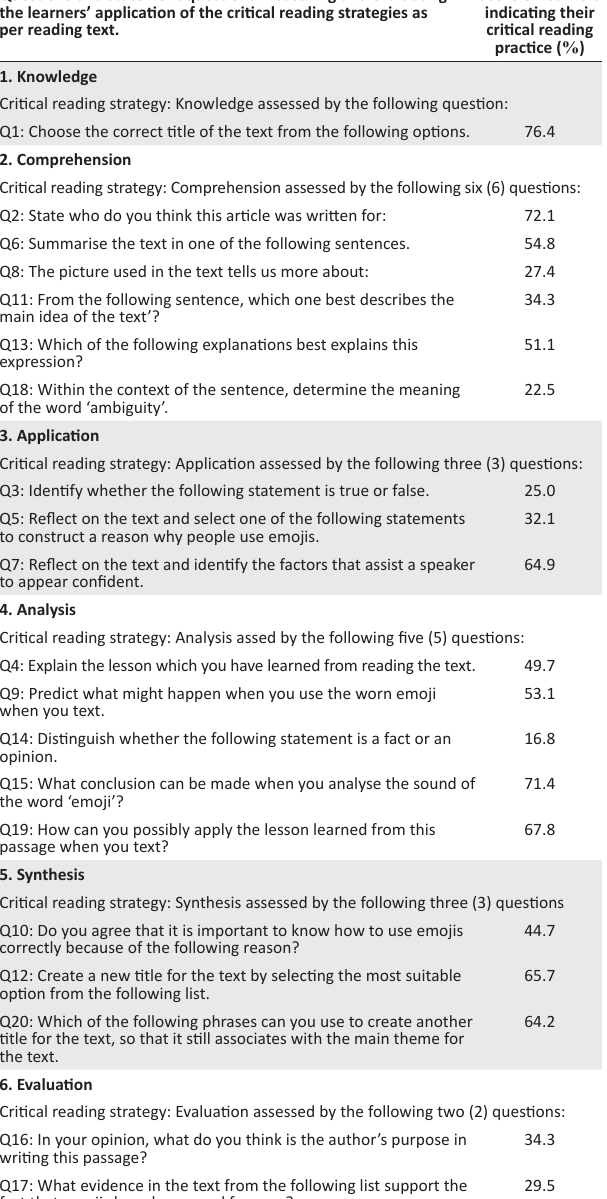
TABLE 3: Comprehension activity measurement and evaluation instruments reflecting the learners’ critical reading practices as scores obtained ( N = 166). Questions and statement questions measuring and evaluating the learners’ application of the critical reading strategies as per reading